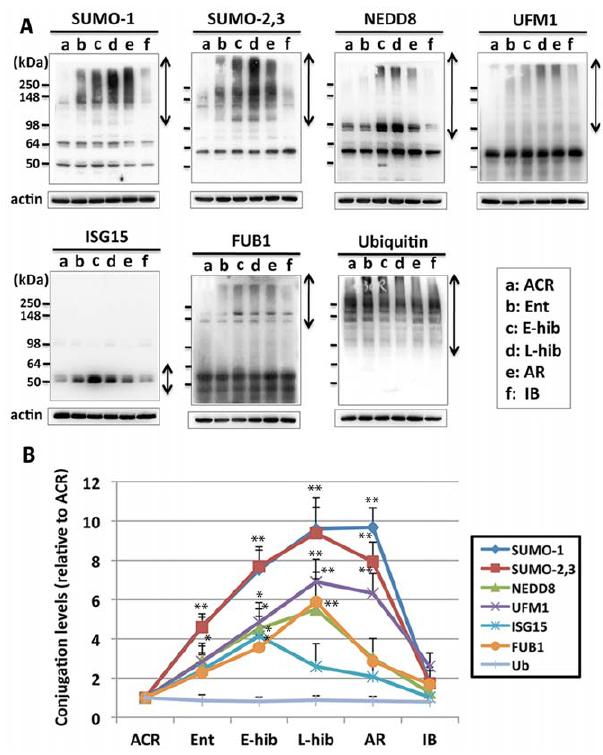
Figure 1. Protein Conjugation by various ULMs increases during hibernation torpor in the brains of 13-lined ground squirrels. (A) Representative Immunoblots of various ULMs in the brain samples from different stages of hibernation cycle. Arrow in each panel shows the molecular weight range of conjugates of the ULM indicated on top of the panel. a: ACR (active in the cold room); b: Ent (entrance); c: E-hib (early hibernation); d: L-hib (late hibernation); e:AR (arousal); f: IB (interabout). b -actin served as a loading control. Each immunoblot is representative of at least three different brain samples at each time point. (B) Quantitative analyses of the conjugates of various ULMs from three independent experiments. Cropped areas are shown by arrows; densities were measured, normalized by corresponding b